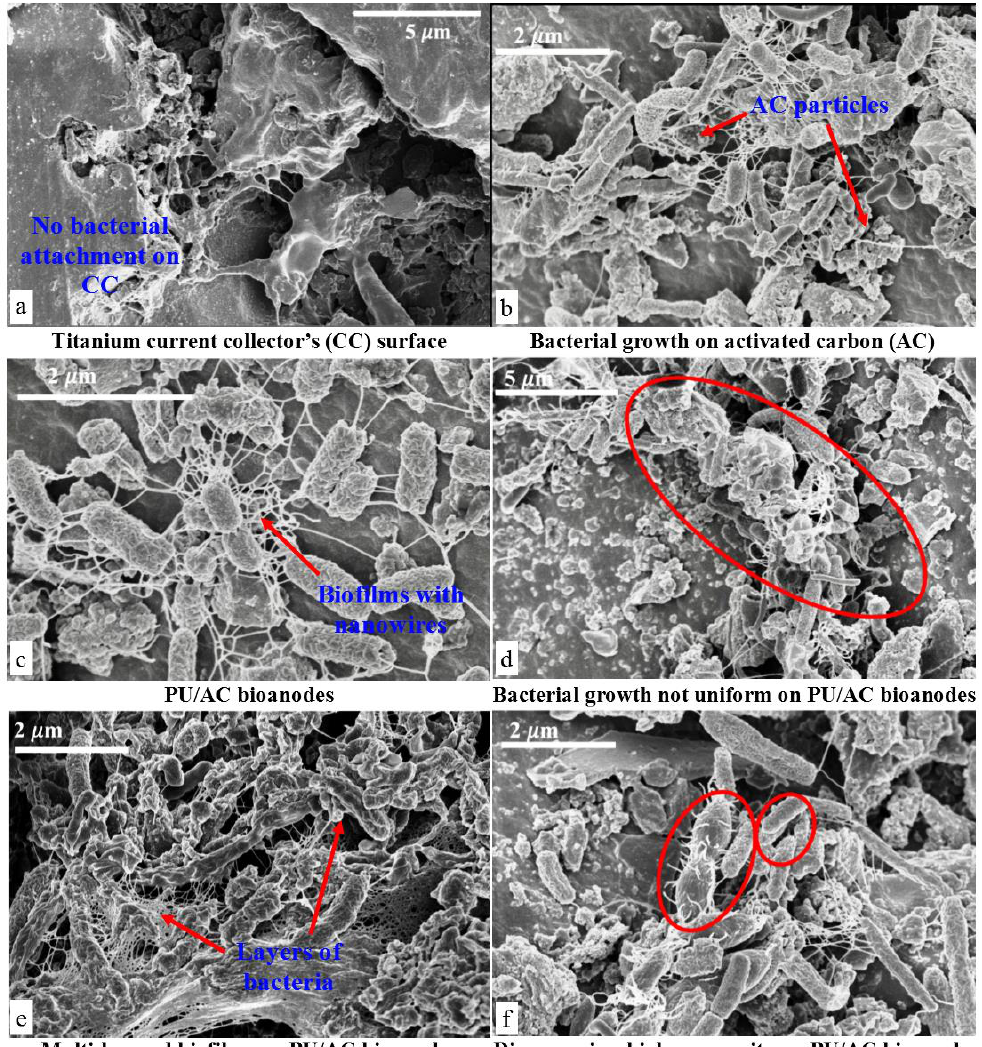
Figure 7. SEM Images of electrochemically active bacteria (EAB). ( a ) Surface of the Titanium current collector after de-construction of MFCs. ( b ) Biofilm development on PU/AC composite showing a strong interaction between microbial nanowires and AC particles. ( c ) PU/AC composite with a self-assembled biofilm, showing nanowires (pili) development. ( d ) Biofilm growth was not uniformly developed on PU/AC composites. ( e ) Multi-layered biofilm formation and solid deposits after 70 days of operation in the reactor where anolyte was used as inoculum. ( f ) Diverse microbial community on the PU/AC bioanode.